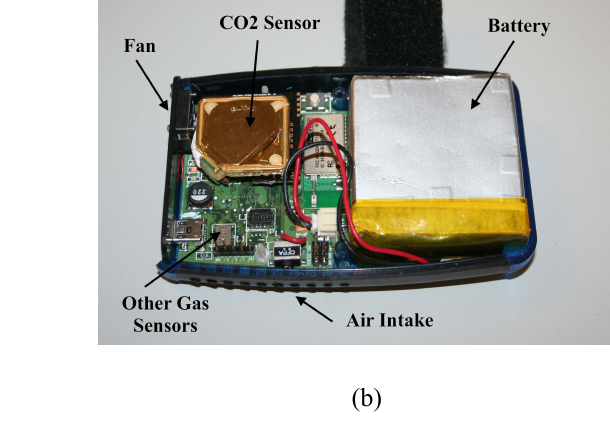
Figure 6. (a) The Denver air quality monitoring station; (b) the M-Pod sensing